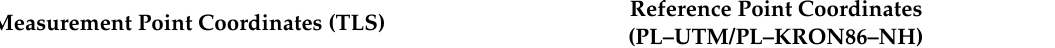
Table 3. Measurement point coordinates in the local system and reference point coordinates in the secondary